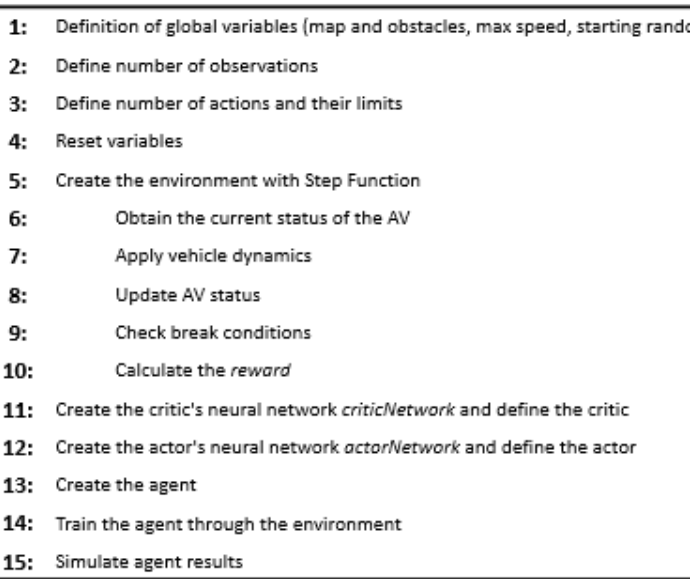
Figure 2. Flowchart of the Lyapunov function surface graphics obtained.